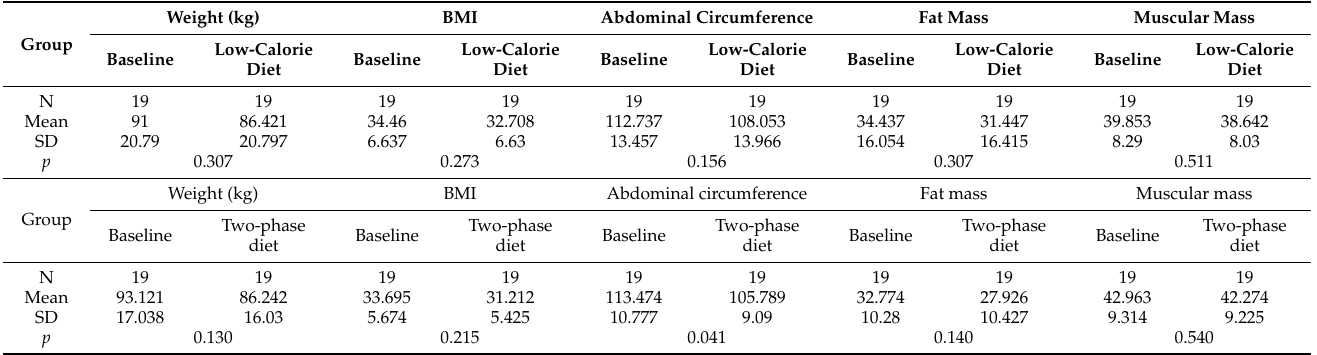
Table 1. Mean values of anthropometric measurements of the total number of participants (N) belonging to baseline, low-calorie diet, and two-phase diet groups. SD: Standard